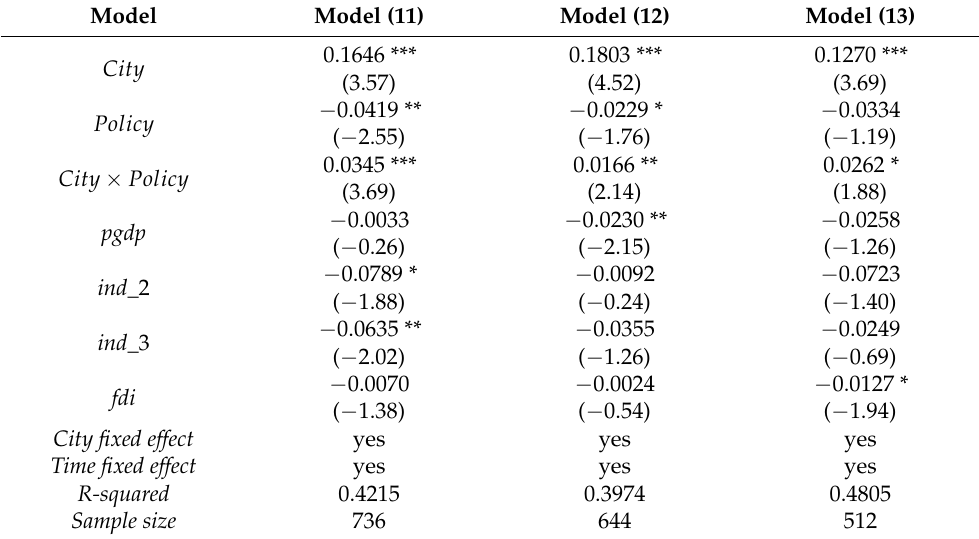
Table 4. Sample expansion test